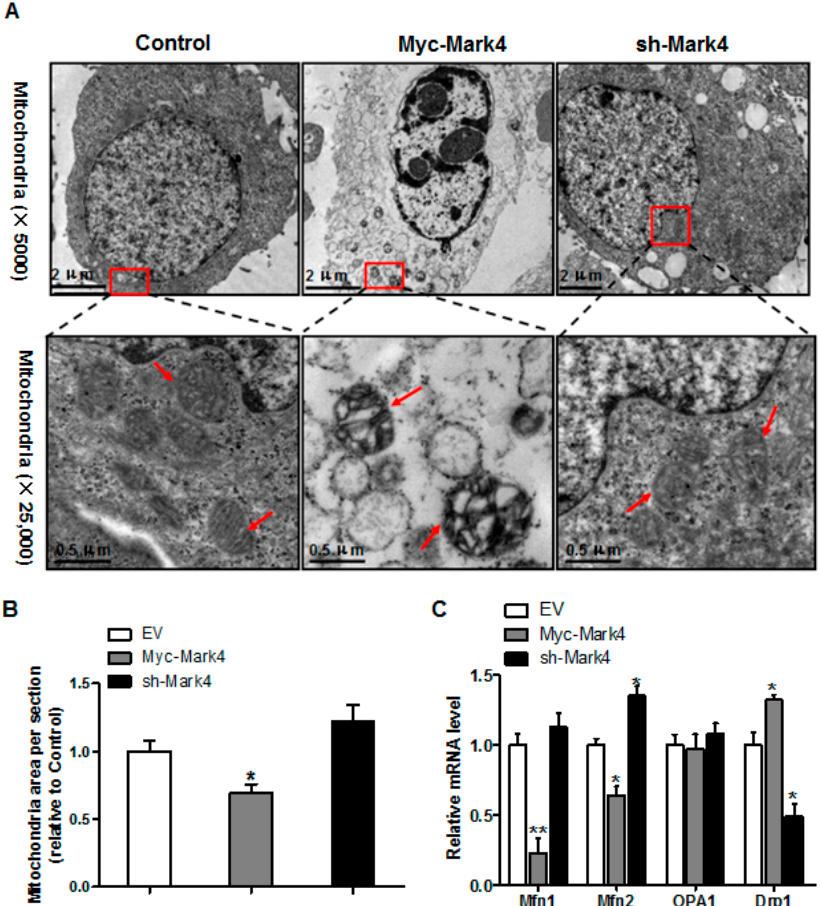
Figure 4. Effects of MARK4 on mitochondrial structure in pig primary trophoblast cells. ( A ) Repre- sentative transmission electron microscopy images at original magnifications of ×5000 and ×25,000 in primary trophoblast cells after transfection with Myc-MARK4 and sh-MARK4 for 48 h. Cells were then incubated with 400 µ M NEFA for 36 h; ( B ) Quantification of mitochondria area in ( A ) relative to control group (analysis of 10 random images per cell section, n = 3); ( C ) Relative mRNA expression of mitochondrial fission and fusion-related regulators after transfection with Myc-MARK4, sh-MARK4 for 48 h in cytotrophoblasts. Cells were then treated with 400 µ M NEFA for 36 h ( n = 3). Values are expressed as mean ± SEM. ** p < 0.01; * p < 0.05 compared with the control group. NEFA: non-esterified fatty acid; Myc-MARK4 group: over expression of MARK4 group; sh-MARK4 group: knock down of MARK4 group; Control: empty vector (EV) group; Red arrow: mitochondria.